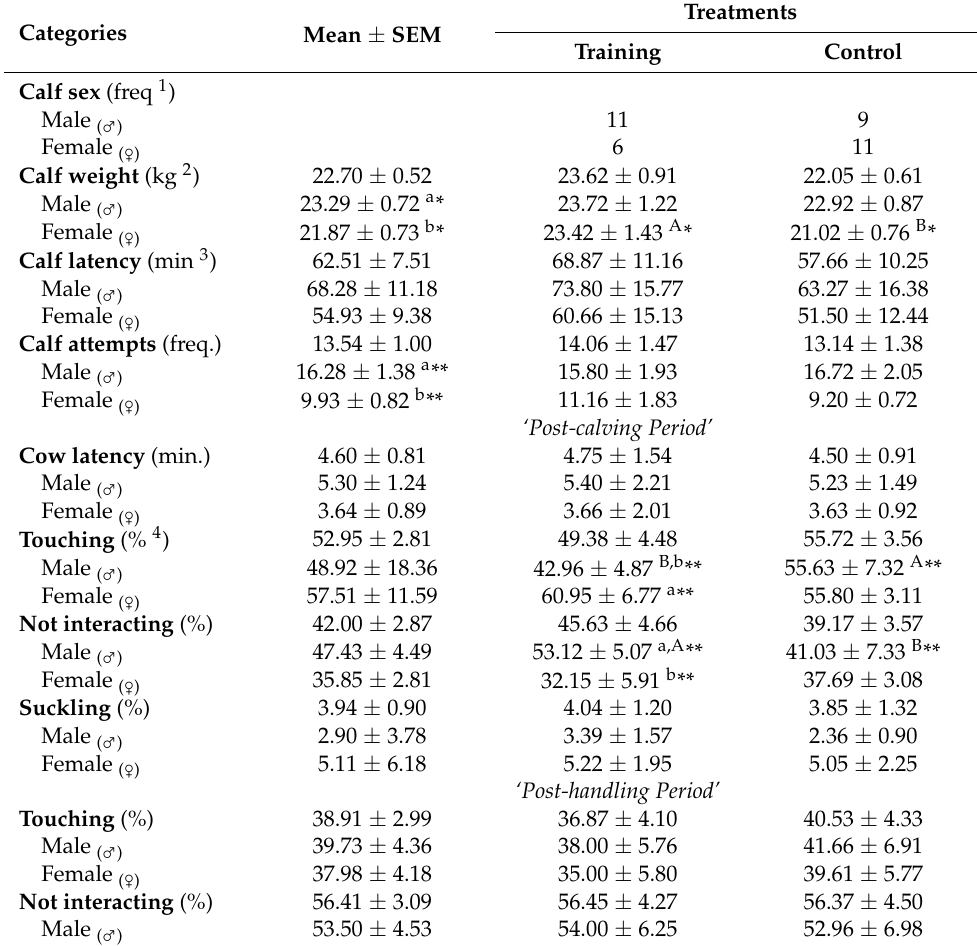
Table 2. Means ( ± standard error) of primiparous Gyr dairy cow behaviors and calf sex, behavior, and weight during the post-calving and post-handling